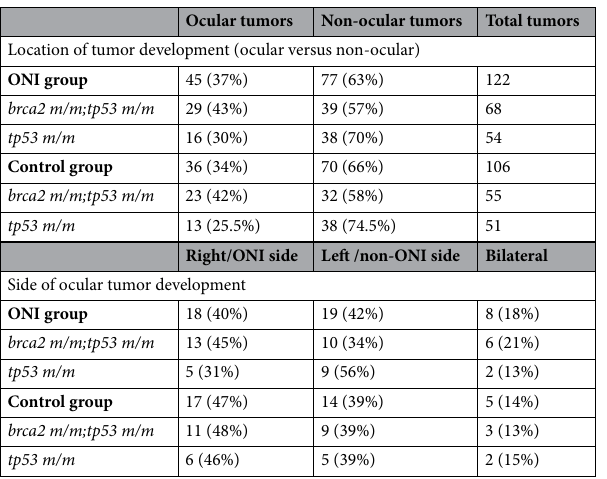
Table 1. Characteristics of tumor development in zebrafish receiving optic nerve injury (ONI) versus control zebrafish.